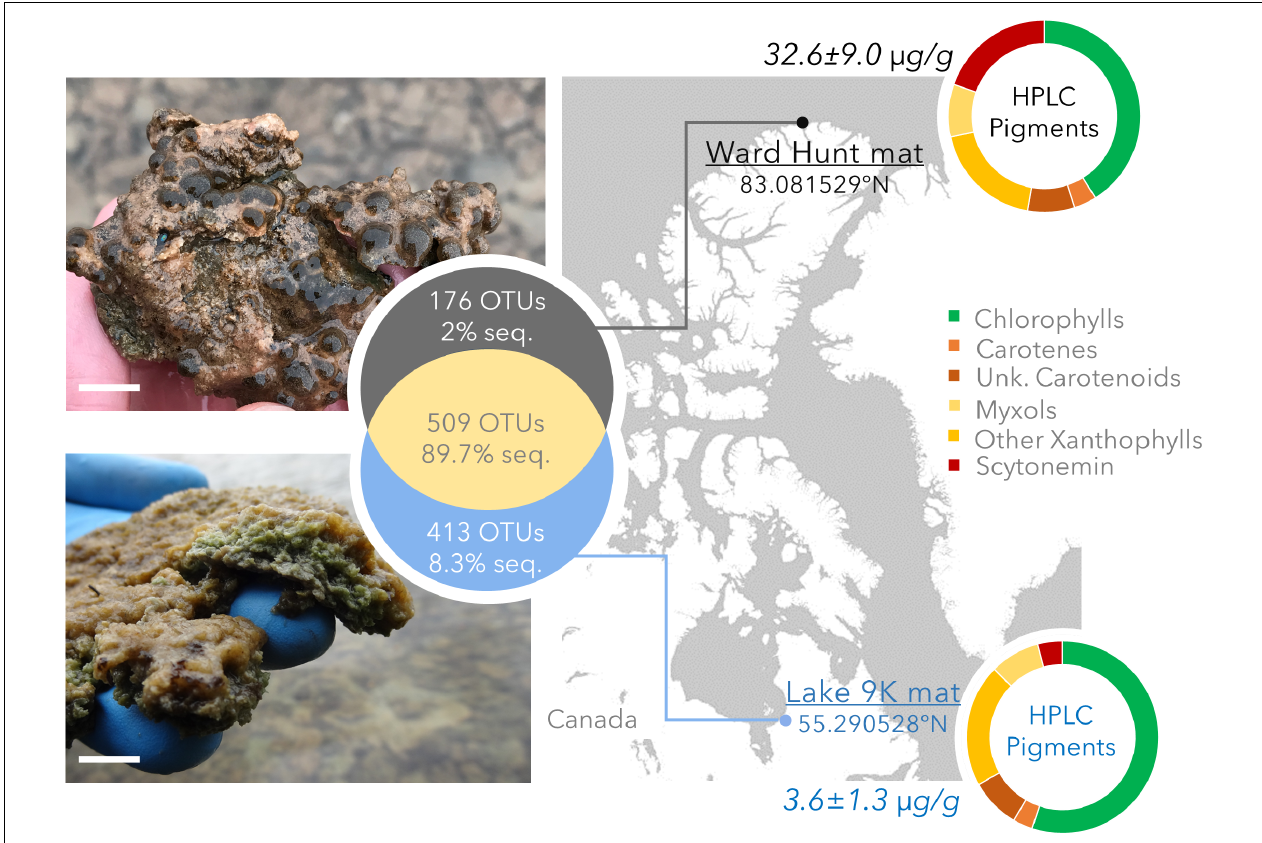
FIGURE 1 | Study sites with geographical position, photographs of the mats, pigment concentration ( µ g pigment/dry weight mat) and pigment composition determined by HPLC. The top image and pigment profile are for the Ward Hunt Lake mats, and the bottom image and pigment profile are for the Lake 9K mats. Chlorophylls: includes bacteriochlorophylls. Unk.: unknown and non-characterized pigments. The white scale bar represents 1 cm at the center of the photographs. The Venn diagram shows the number of unique and shared OTUs detected by 16S rRNA gene sequencing, with the corresponding percentage of sequences in the whole